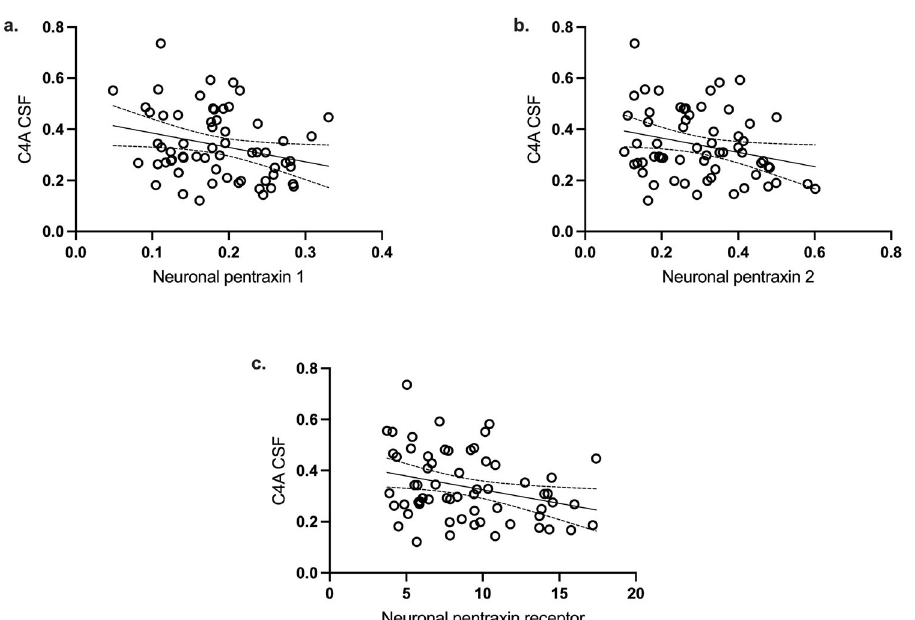
Fig. 4 | Correlations ofcerebrospinal fl uid C4Aand C4B protein concentration with markers of synapse density. Cerebrospinal fl uid (CSF) from 19 healthy controls, 14 patients with fi rst-episode psychosis (FEP) who developed schizo- phrenia and 29 patients with fi rst-episode psychosis (FEP) who developed schizo- phreniaintheKaSPcohortwereanalyzed.Medianage:27years(interquartilerange 22 – 32), 40 males and 22 females. CSF C4A levels (adjusted for age, sex, and diag- nosis) were negatively correlated to CSF levels of neuronal pentraxin 1